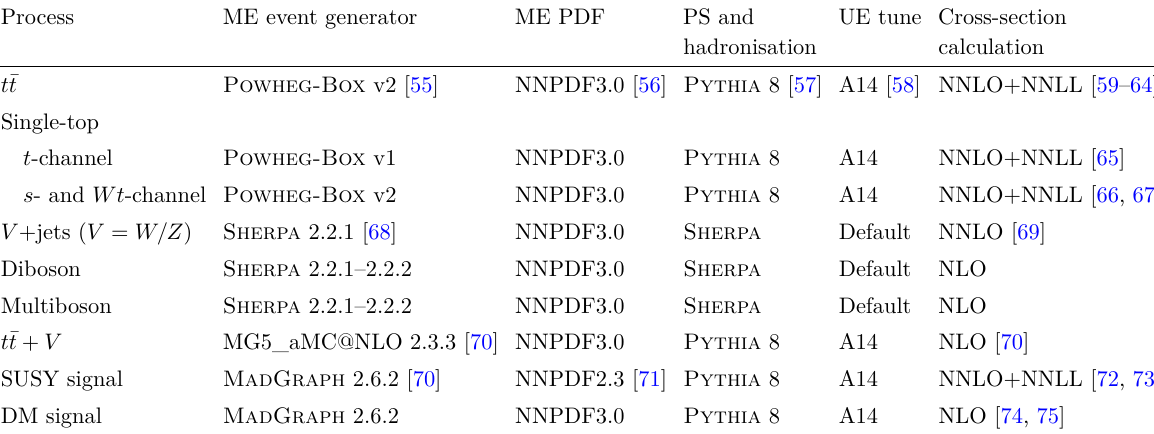
Table 2. Overview of the nominal simulated samples. The cross-sections of top, single-top and SUSY samples were calculated at next-to-next-to-leading order (NNLO) with the resummation of soft gluon emission at next-to-next-to-leading-logarithm (NNLL) accuracy. The V +jets background samples were calculated at NNLO. The cross-sections of other background and DM samples were calculated at next-to-leading order